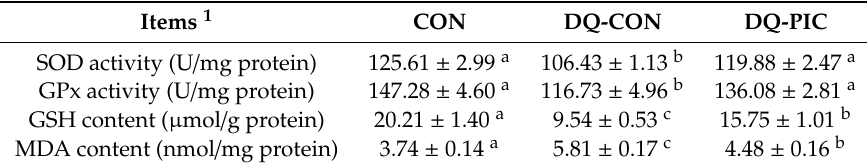
Table 5. E ff ects of piceatannol supplementation on the redox status in the liver of diquat-induced piglets.